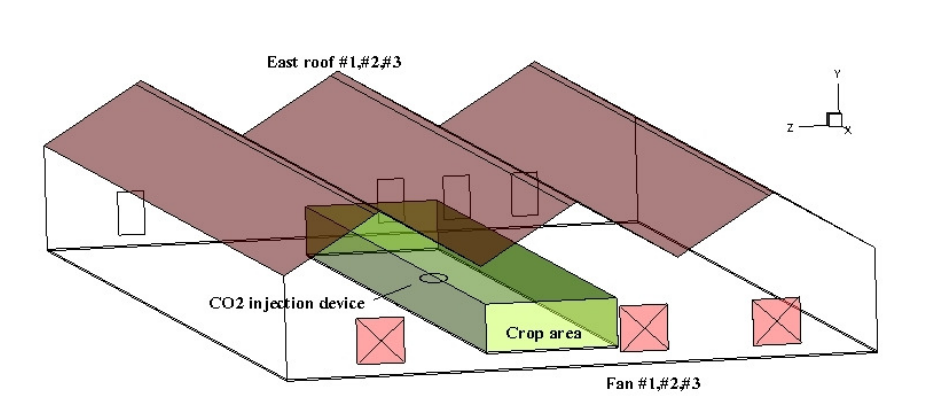
Figure 9. Profile of the control variables and simulated crop area in the